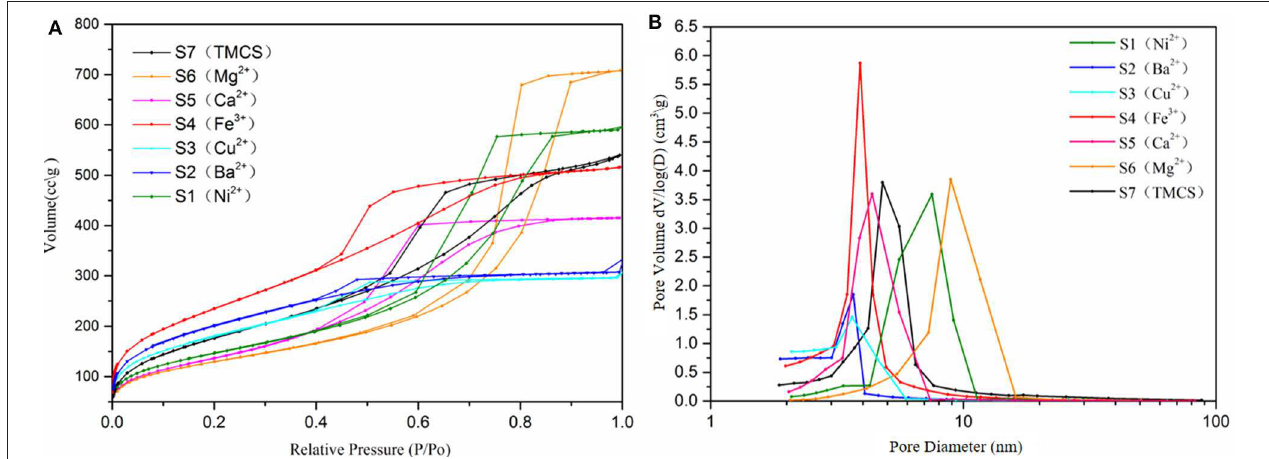
FIGURE 2 | N 2 adsorption/desorption isotherms (A) and pore size distributions (B) of the composite silica